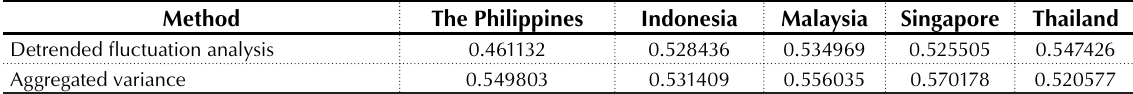
Source: Günay (2016).